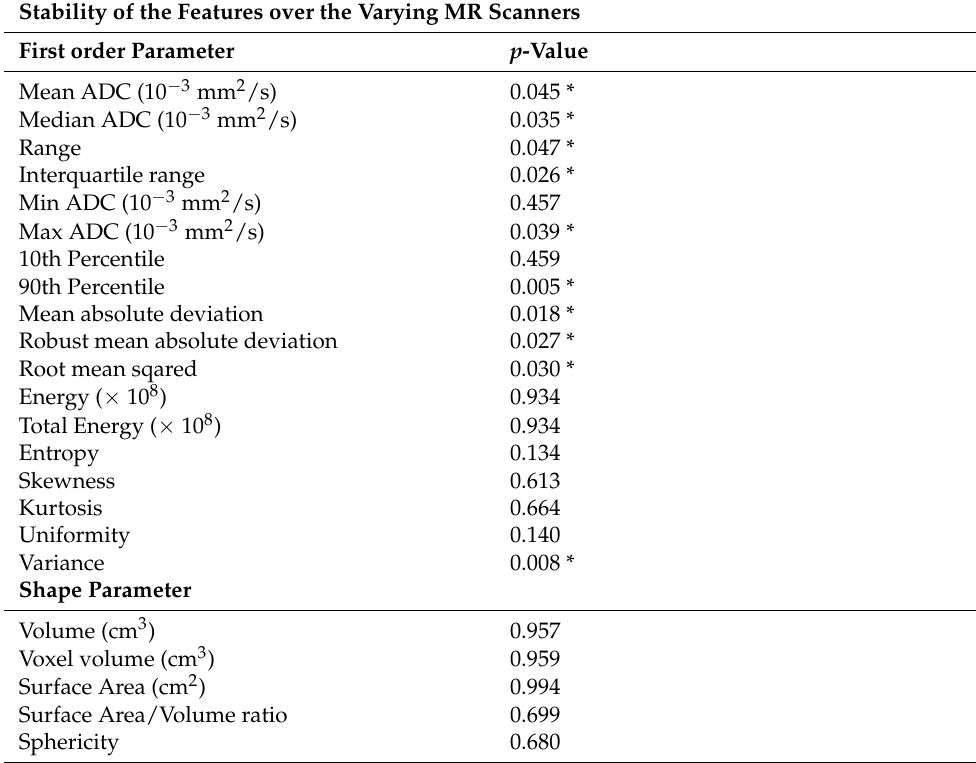
Table A2. Feature stability over the 2 main MR scanners used. *: statistically